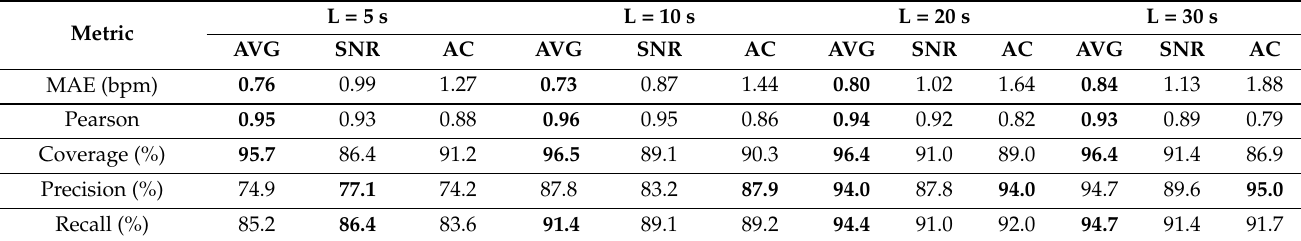
Table 2. Statistical results obtained by Seg-based methods on Dataset A, where subjects wear a face mask. Boldface character denotes the best result per